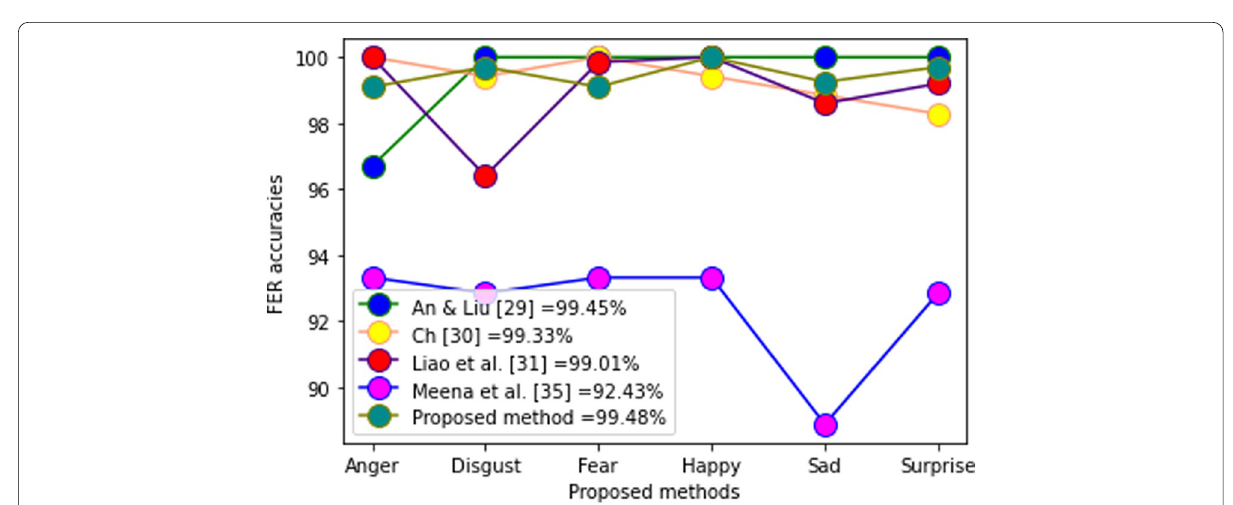
Fig. 18 Performance of 6 FER prototype in CK